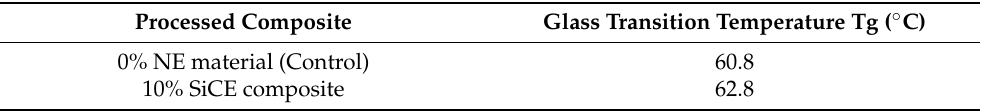
Table 2. Results of DSC analysis for all processed ceramic incorporated E-glass fiber reinforced epoxy composites.